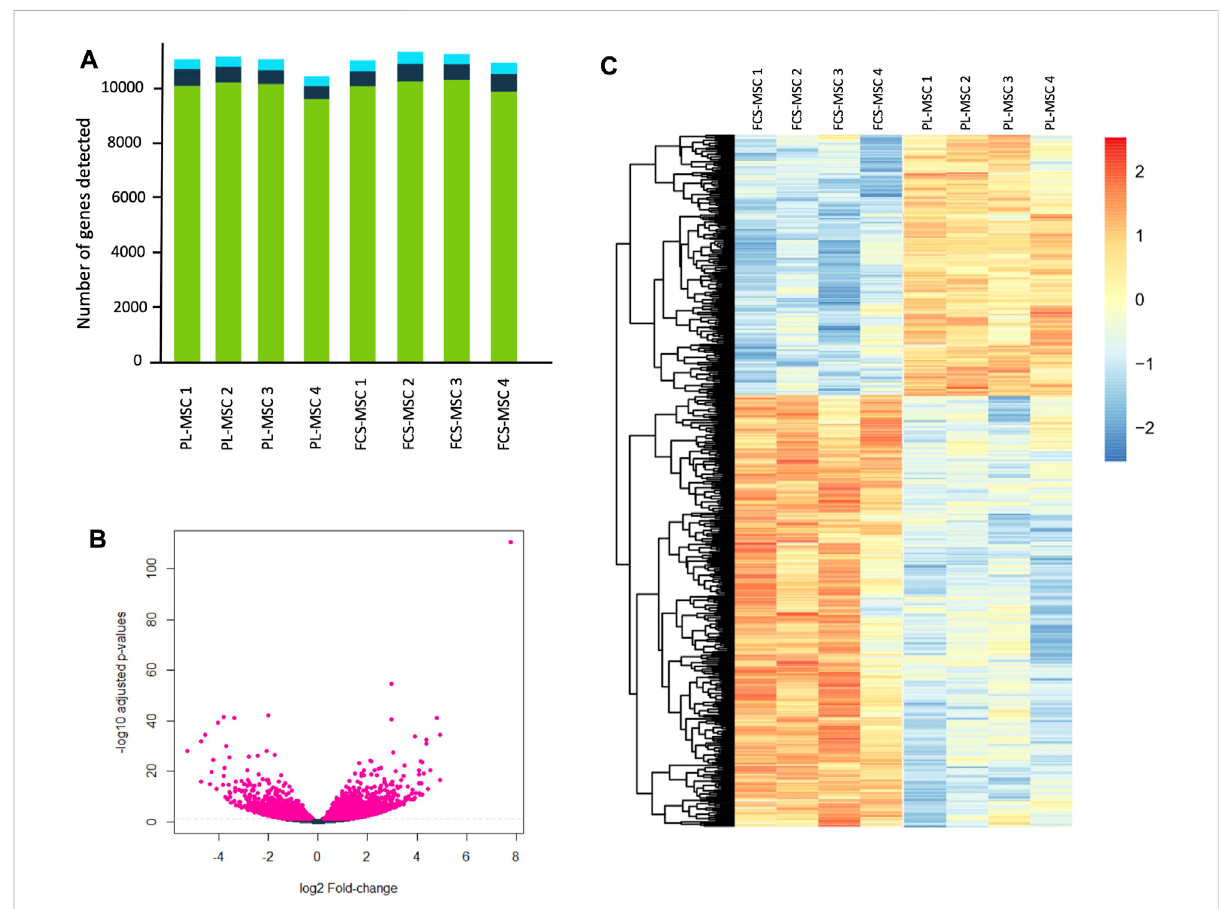
FIGURE 2 RNA sequencing of FCS-MSCs and PL-MSCs. (A) : Overview of the number of transcripts detected per sample for 4 different donors. The green bars represent coding genes, dark blue bars long non coding RNA and light blue bars other RNA species. (B) : Volcano plot showing -log10 adjusted p -values in function of the log2 fold change for FCS-MSCs versus PL-MSCs. Pink points indicate signi fi cantly differential expressed genes at FDR < 0.05. FDR: false discovery rate. (C) : Heatmap showing the top 500 differentially expressed genes according to adjusted p -values at FDR < 0.05 for FCS-MSCs versus